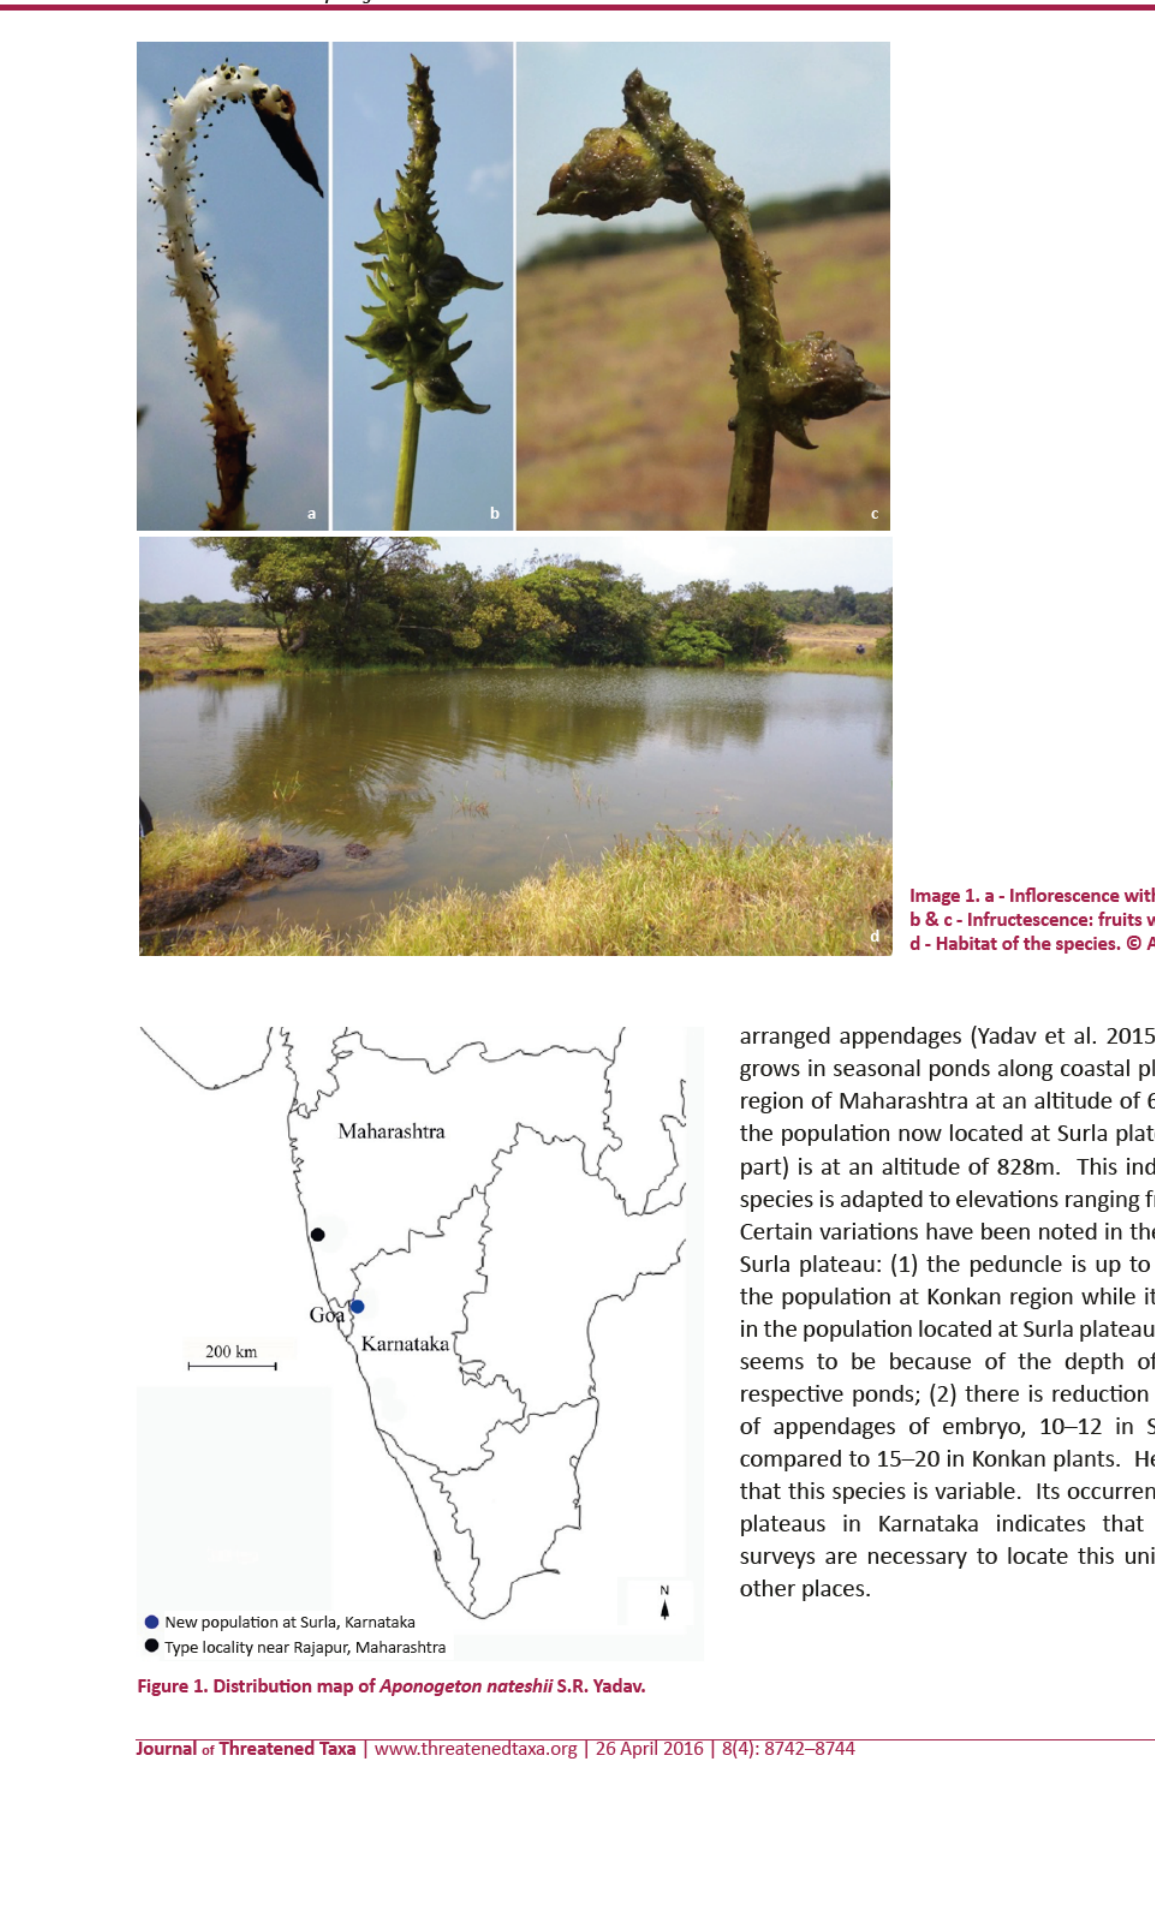
Ftigure 1. Dtistrtibution map of Aponogeton nateshtiti S.R.